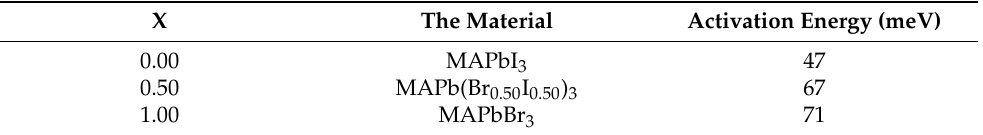
Table 5. E a calculated by Arrhenius plots of perovskite films above 160 to 300 K range of temperature. X The Material